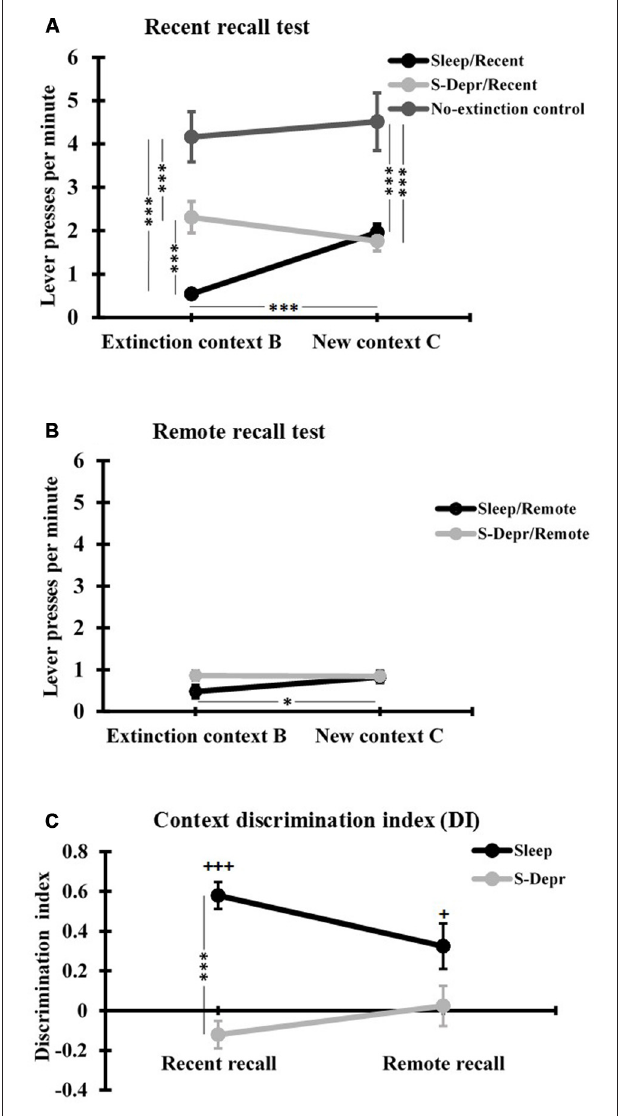
FIGURE 3 | (A) Mean ( ± SEM) lever presses per minute at the Recent recall, for the Sleep/Recent, S-Depr/Recent and No-extinction control groups, and (B) at the Remote recall, for the Sleep/Remote and S-Depr/Remote groups, during testing in the extinction context (Context B) and in the different context (Context C). (C) Discrimination index (DI) for the lever press responses in context B and C of the Sleep and S-Depr groups at the Recent and Remote recall tests. Significance for post hoc pairwise tests is indicated ∗∗∗ p < 0.001, ∗ p < 0.05. In (C) +++ p < 0.001, + p < 0.05 indicate significance against “0”.